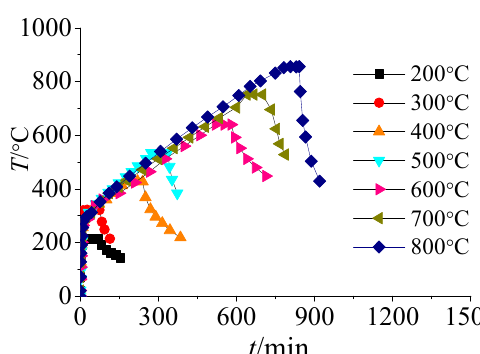
Figure 3. Temperature increase in the furnace.